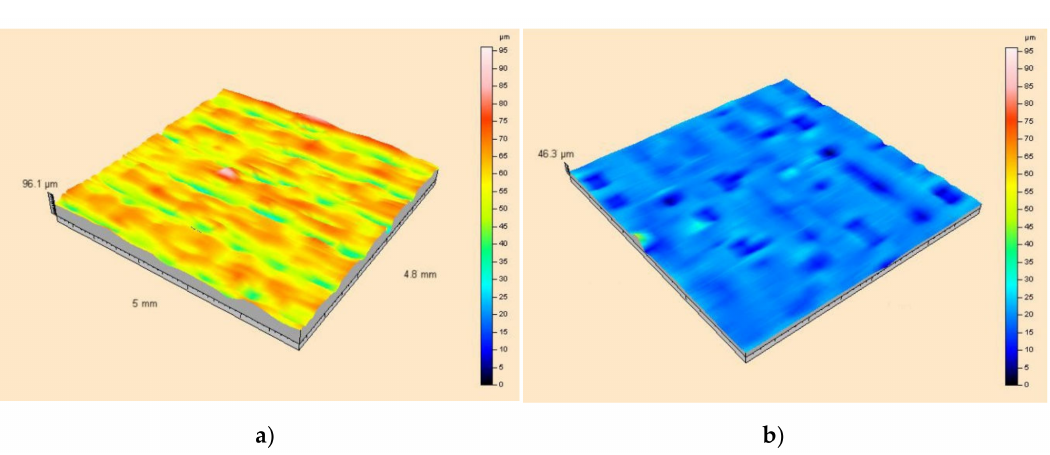
Figure 13. Topographic 3D maps after Gaussian correction, showing surface roughness: ( a ) for a raw surface; ( b ) for a surface with a silver